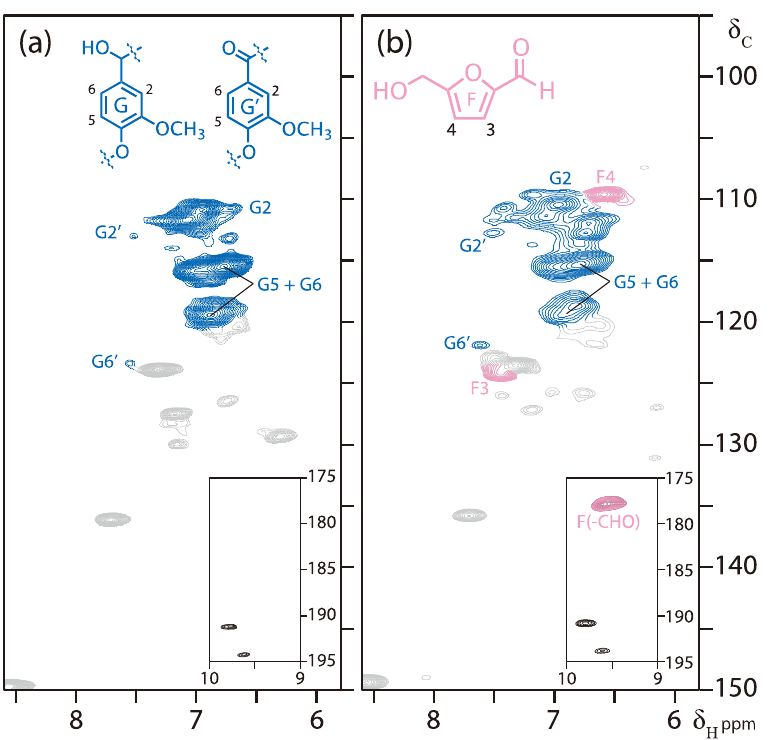
Figure 3. HSQC-NMR spectra in the aromatic region of the wood (Japanese cedar) ( a ) and the su- crose/citric acid type adhesive wood-based molding (W80) ( b